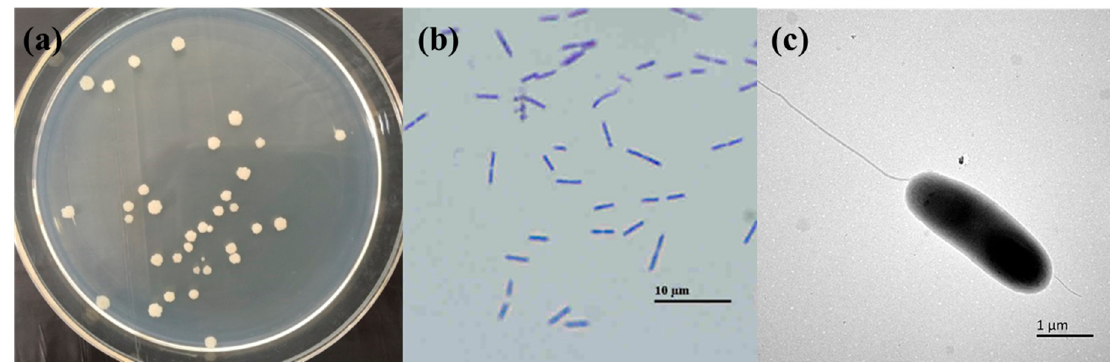
Figure 1. Morphological characters of strain DMN6. ( a ) Growth on LB medium. The colony was cultivated at 37 °C for three days; ( b ) Microscopic image (×1000); ( c ) Transmission electron microscope (×15,000). Table 2. The biochemical identification of DMN6.